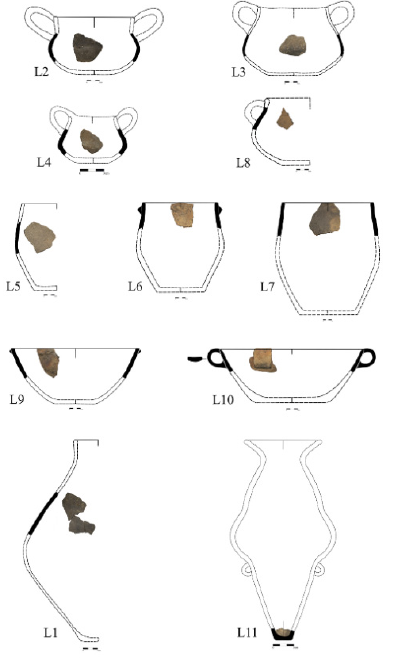
Figure 2. The analyzed pottery samples from the Piatra Neamt